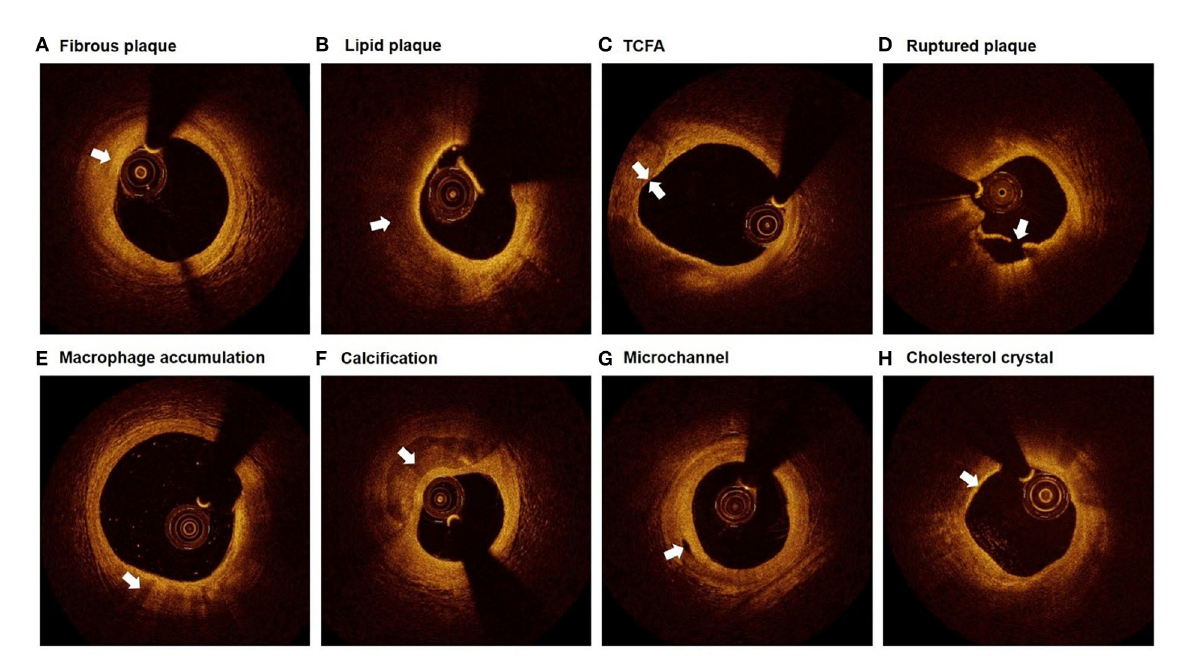
FIGURE2 Representative plaque characteristics in OCT images. (A) Fibrous plaque: homogeneous signal and high backscattering; (B) Lipid plaque: poor signal, low backscattering, and diffuse border; (C) TCFA: lipid plaque with maximum lipid arc > 90 ◦ and FCT ≤ 65 µ m; (D) Ruptured plaque: discontinuation of fibrous cap and the formation of cavity; (E) Macrophage accumulation: signal-rich, distinct, or confluent punctuate region with higher intensity than background speckle noise; (F) Calcification: low backscattering, poor or heterogeneous signal, and sharp border; (G) Microchannel: signal-poor tubular structure, present in ≥ 3 consecutive cross-sectional images, and not connected to the vessel lumen; (H) Cholesterol crystal: thin and linear structure with high signal and backscattering. TCFA, thin-cap